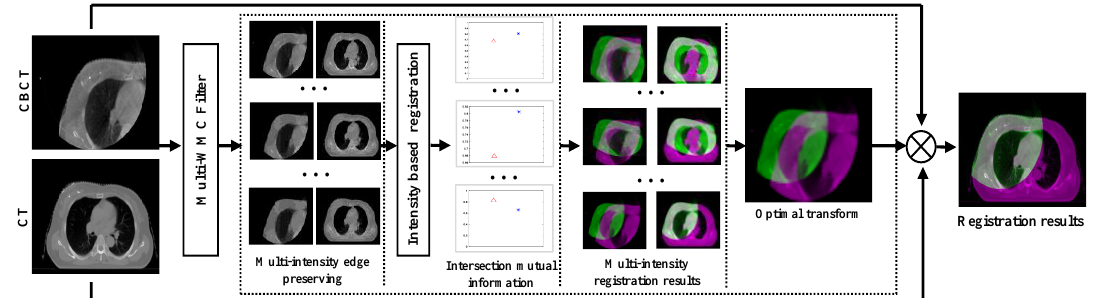
Figure 2. Flowchart of the proposed method.